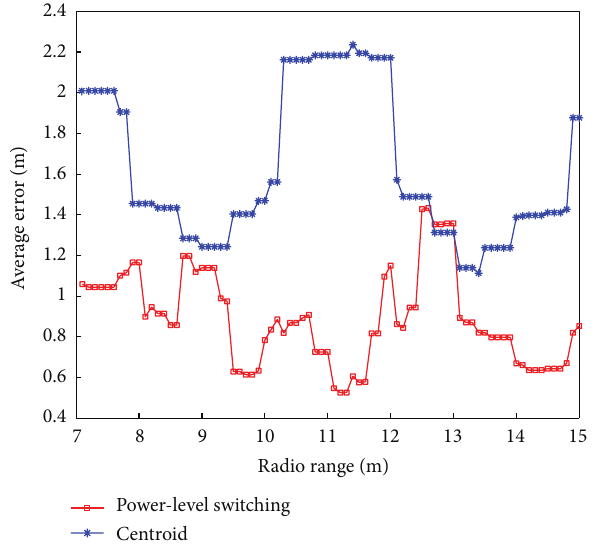
Figure 16: The comparison of location estimation error with centroid model for path 1 movement.